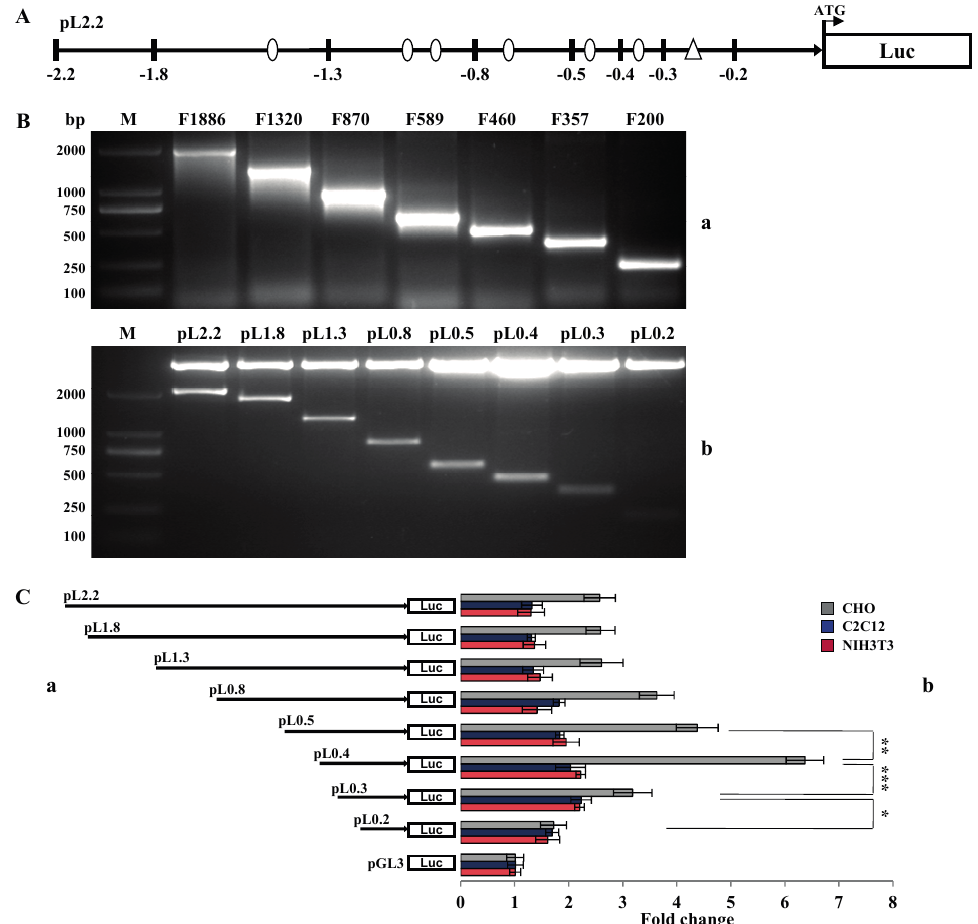
Figure 3. Screening of the core regulatory sequence in BMP15 promoter. ( A ) The schematic diagram of vector pL2.2. The sites of truncated constructs are denoted in black bars. Circle dots indicate the potential DNA binding sites, and a triangle indicates the predicted transcription start site of porcine BMP15 ; ( B ) PCR amplified fragments of truncated BMP15 promoter ( a ) and the constructs digested by Xho I and Hind III ( b ). M, 2000 bp DNA marker; and ( C ) Luciferase assays of the truncated constructs in CHO, C2C12, and NIH3T3 cells. The pGL3-Basic vector was used as control. Values are represented as mean ± SD, * p < 0.05, ** p < 0.01, *** p < 0.001, n =